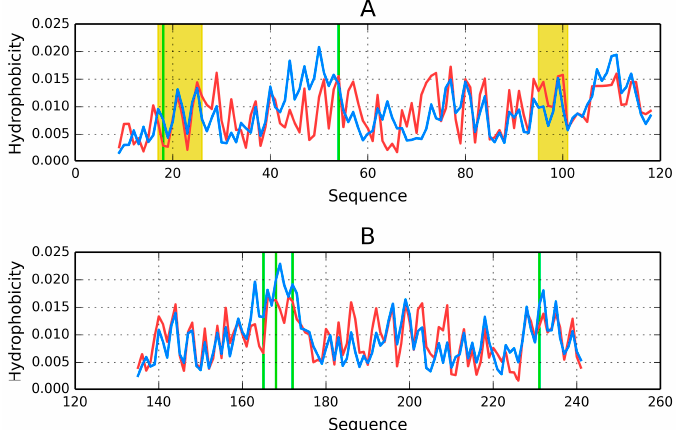
Figure 7. Theoretical ( blue line ) and observed ( red line ) hydrophobicity density distribution profiles. ( A ) CH1 (modified domain); ( B ) CH2 (modified domain). Green lines: positions of disease-related mutations. Yellow area: fragment interacting with actin.